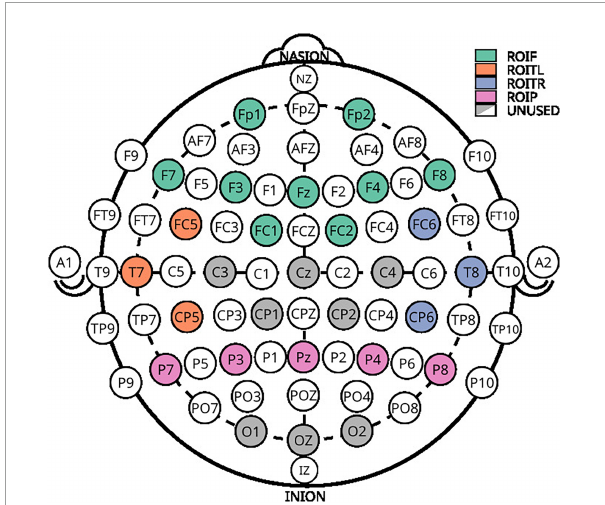
FIGURE3 Electroencephalography layout used for acquisition. Colored electrodes represent the selected positions from the extended 10–20 system.